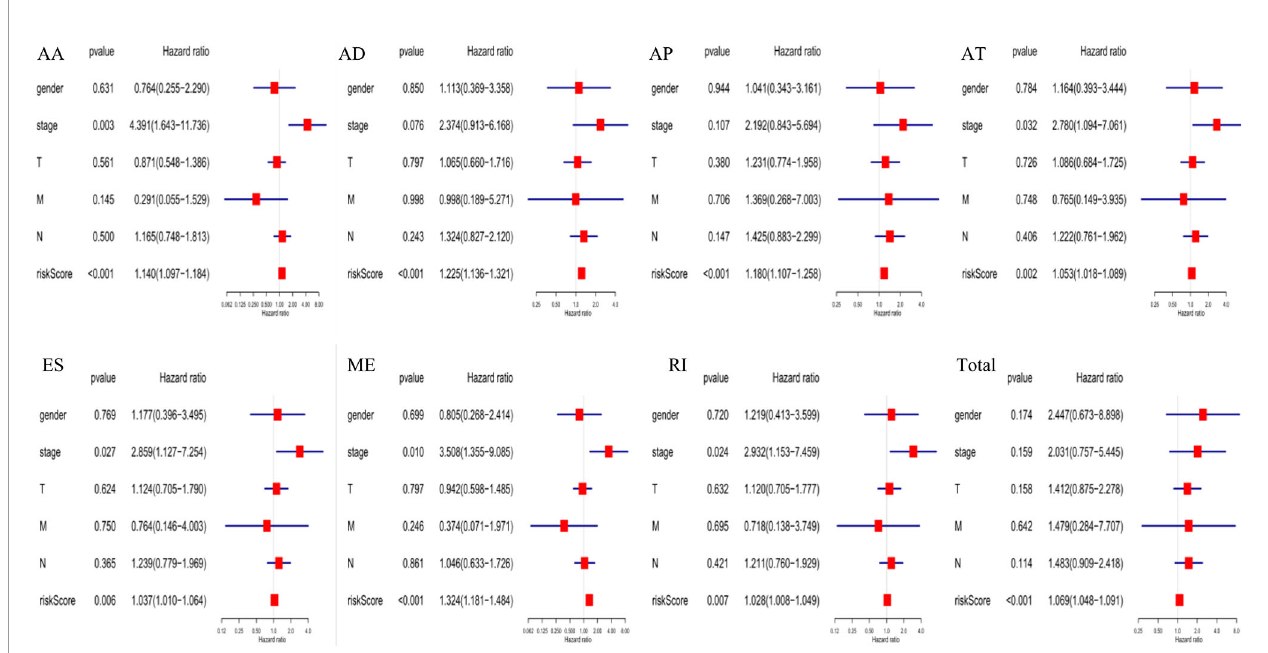
FIGURE 7 | Independent prognostic analysis indicated that the risk score of constructed prognosis signatures could be employed as an independent predictor of EC patients.